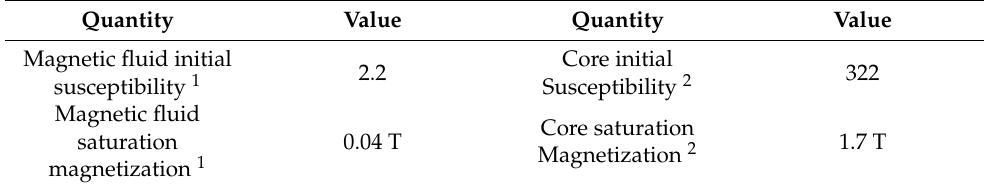
Table A2. Magnetic properties of the magnetic fluid and the